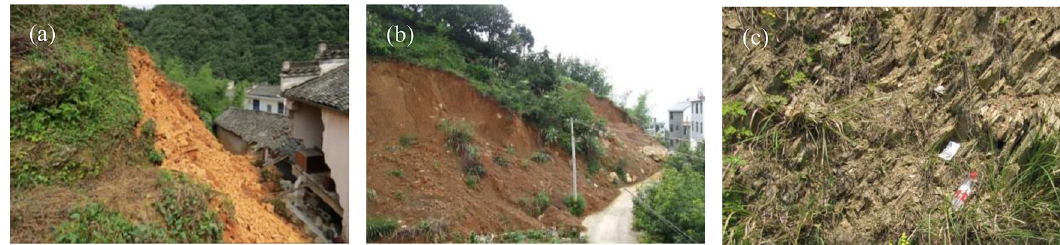
Figure 2: Landslide photos: ( a ) small - scale landslide; ( b ) medium - scale landslide; and ( c ) medium - scale landslide ( part )